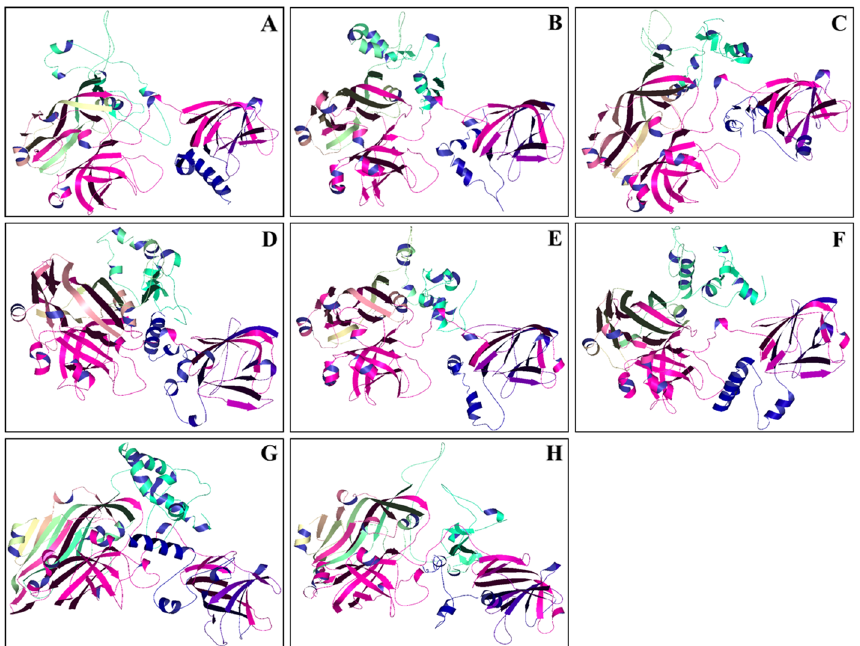
Fig. 2 Generated 3D models of the HEV ORF2. A JF443720 (GT 1); B M74506 (GT 2); C AB222182 (GT 3); D GU119961 (GT 4); E AB573435 (GT 5); F AB602441 (GT 6); KJ496143 (GT 7); and H KX387865 (GT 8). The prediction was carried out using